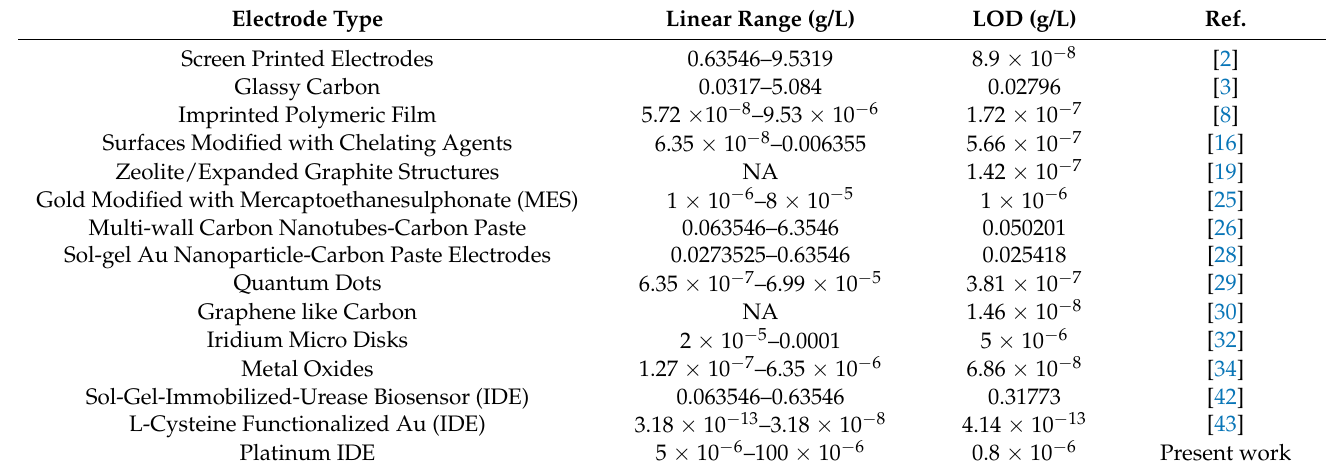
Table 1. Electrochemical sensors for copper